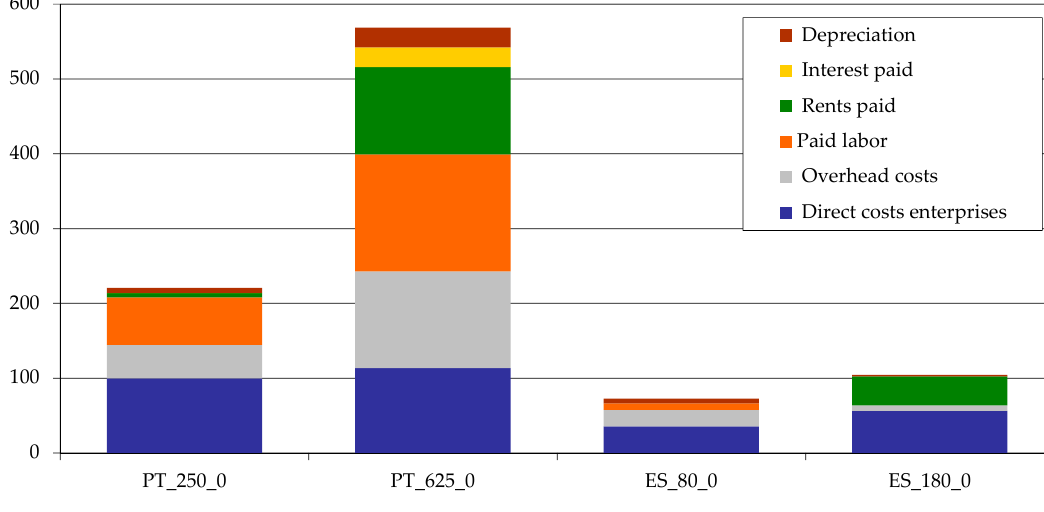
Figure 4. Whole farm costs in absolute values ( € / farm). Source: model results.